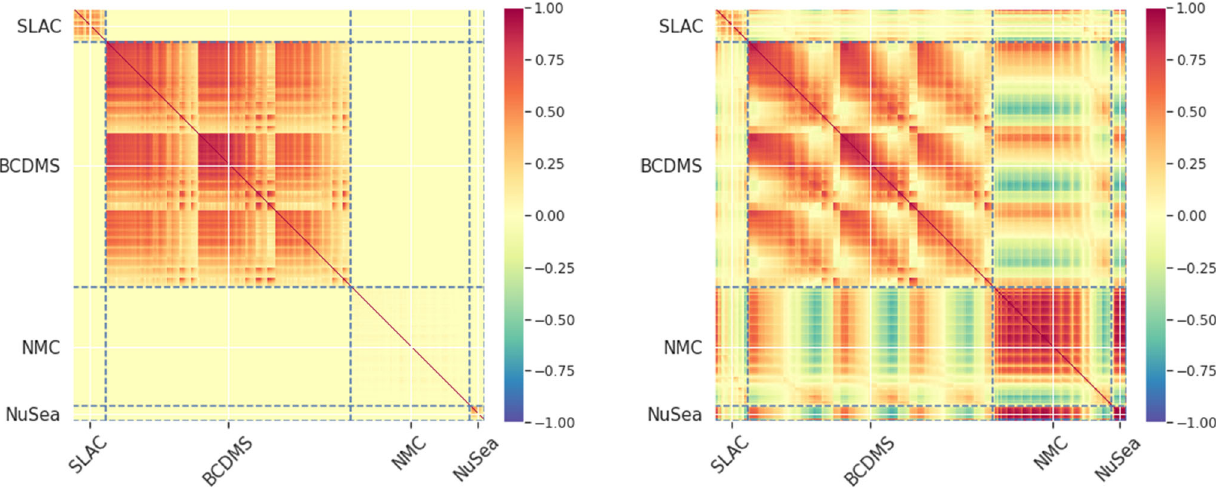
Fig. 4 The experimental (left) and total (right) correlation matrices for the SLAC, BCDMS, NMC and DYE866/NuSea deuteron experiments. The deuteron covariance matrix, added to the experimental covariance matrix to obtain the total covariance matrix, is computed according to Eq. (3)